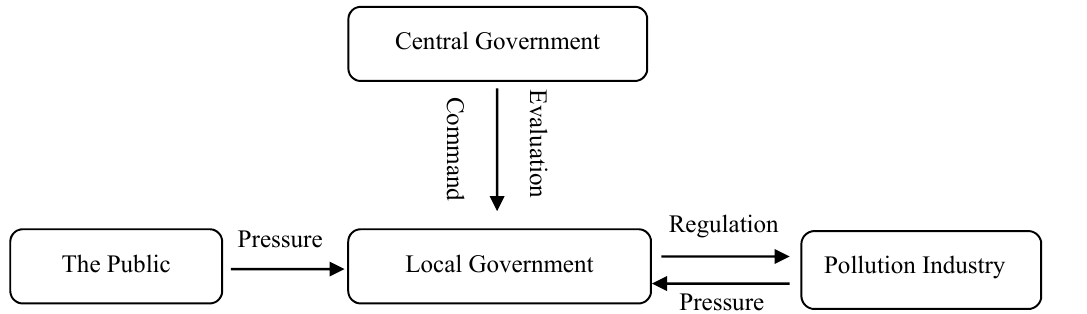
Figure 2. Structure of units related to the local government’s environmental regulation in China.